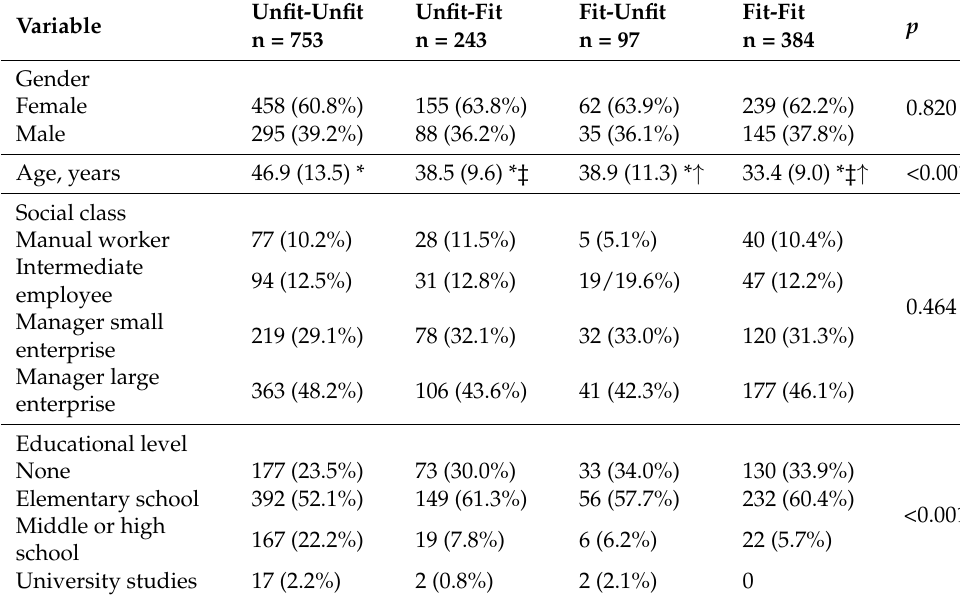
Table 1. Participants’ characteristics of sample individuals across the four groups of change in cardiorespiratory fitness at 6